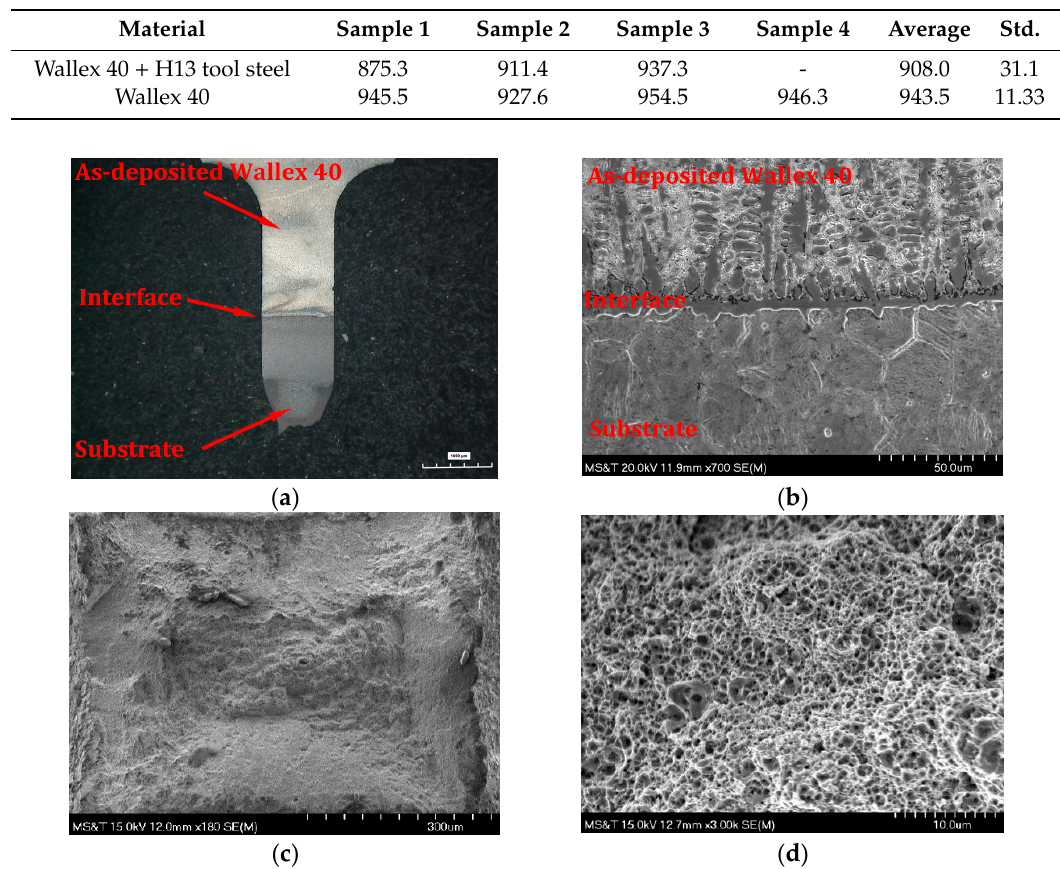
Figure 19. Tensile fracture morphology of Wallex 40 + H13 tool steel sample. ( a ) Overview of the fracture surface in longitudinal section; ( b ) magnified view of the bonding area; ( c ) overview of the fracture surface in cross-section; ( d ) magnified view of the fracture surface in cross-section.